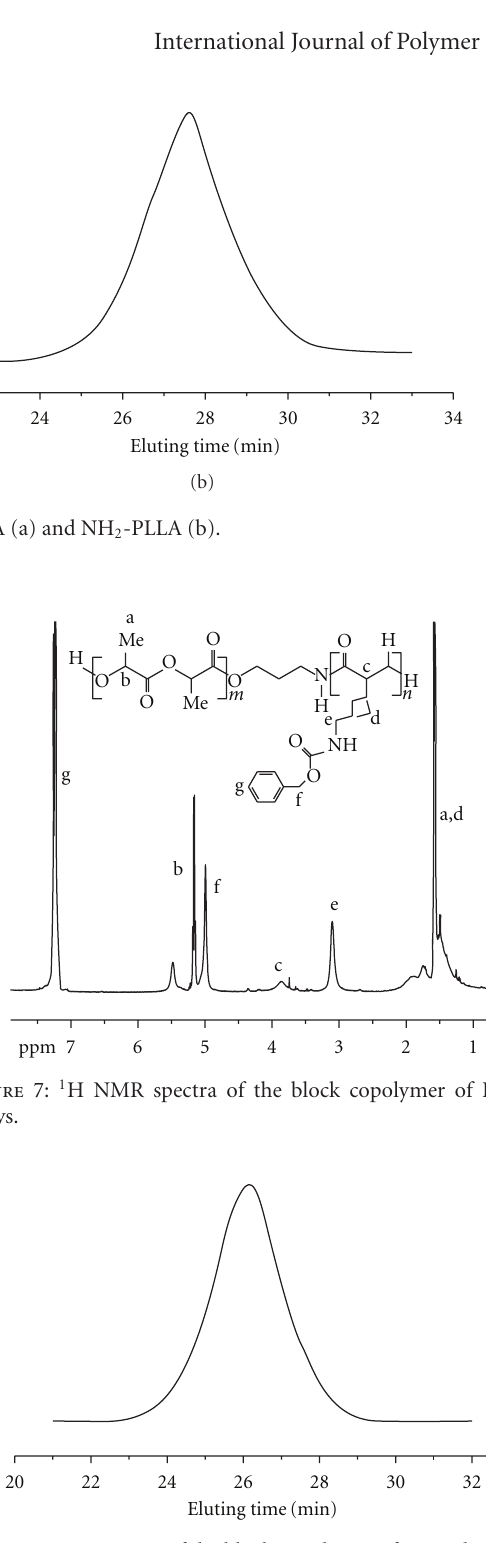
Figure 6: FT-IR spectra of BocNH-PLLA (a), NH 2 -PLLA (b), and PLLA- b -PZLys (c).